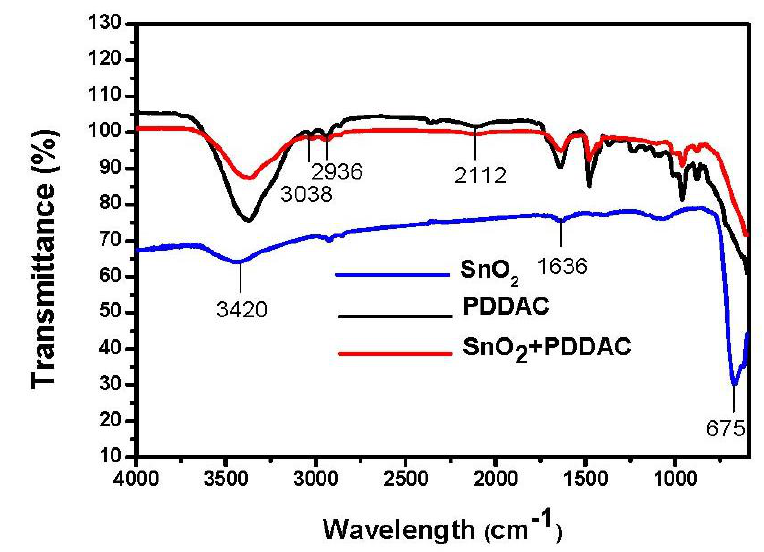
, PDDAC and SnO 2